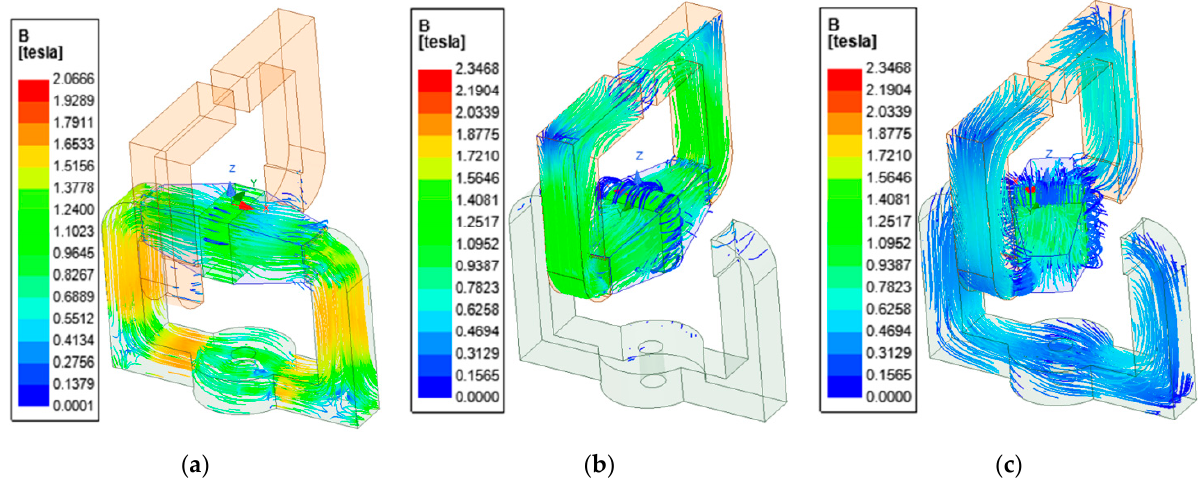
Figure 3. Magnetic field distributions for the exciter with a rotating magnet—the magnetic flux penetrates: ( a ) the lower yoke, ( b ) the working slot, and ( c ) partially the lower yoke and working slot.